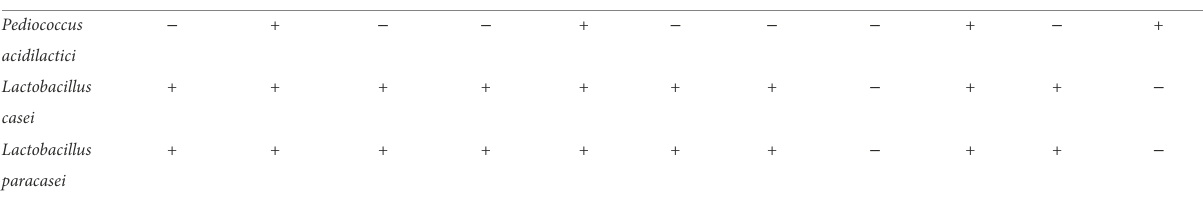
TABLE 2 Biochemical test. Strain/ biochemical